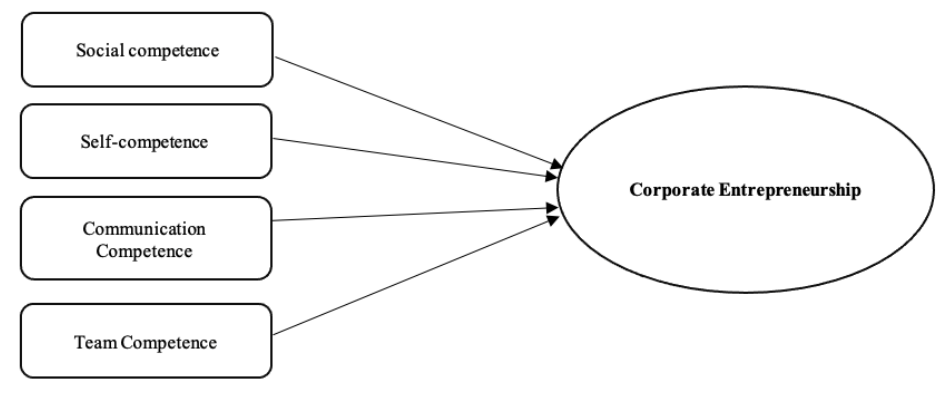
Figure 2: Employees’ Competencies and Corporate Entrepreneurship; Source: Authors Construct,